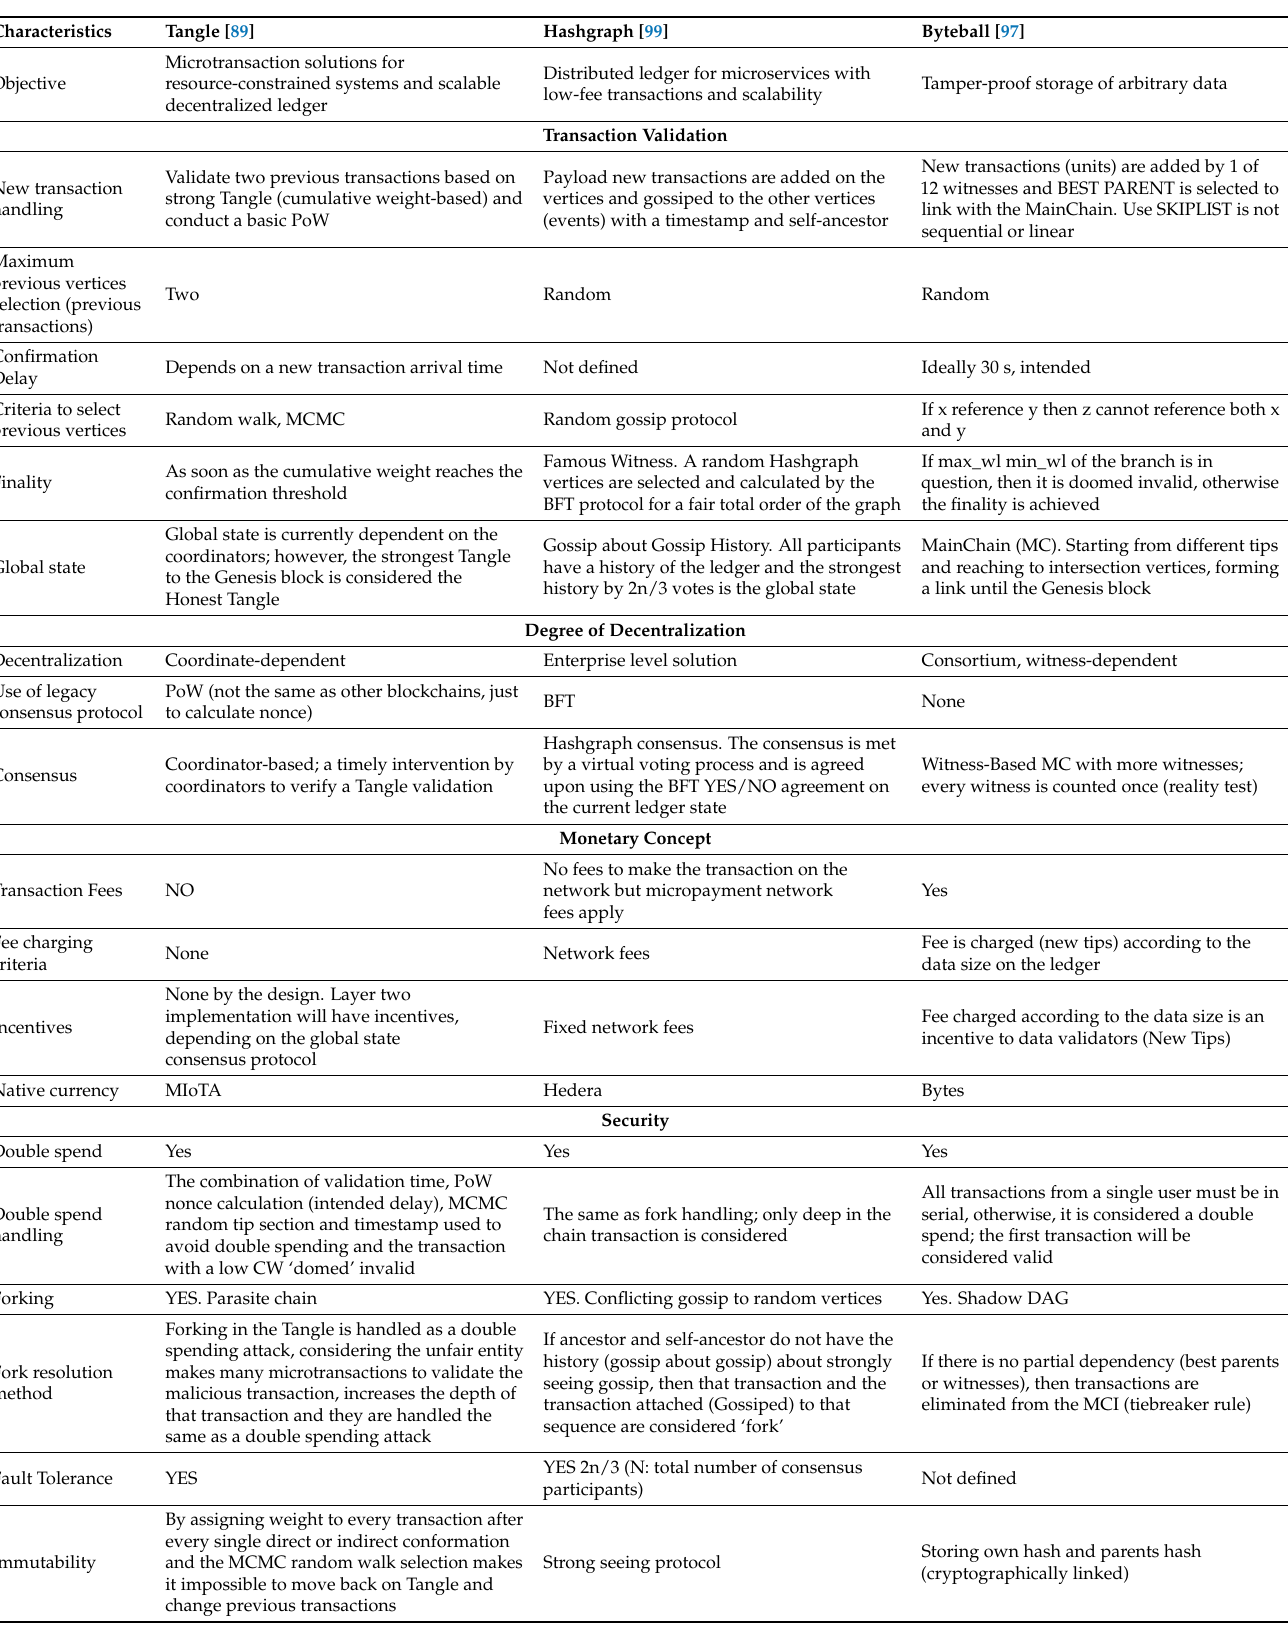
Table 2. DAG-based blockchain